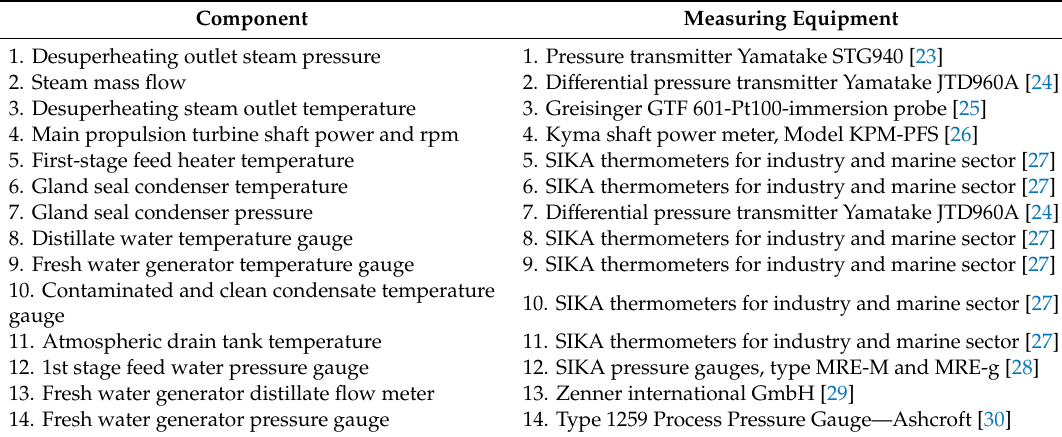
Table 2. Standard marine data collecting